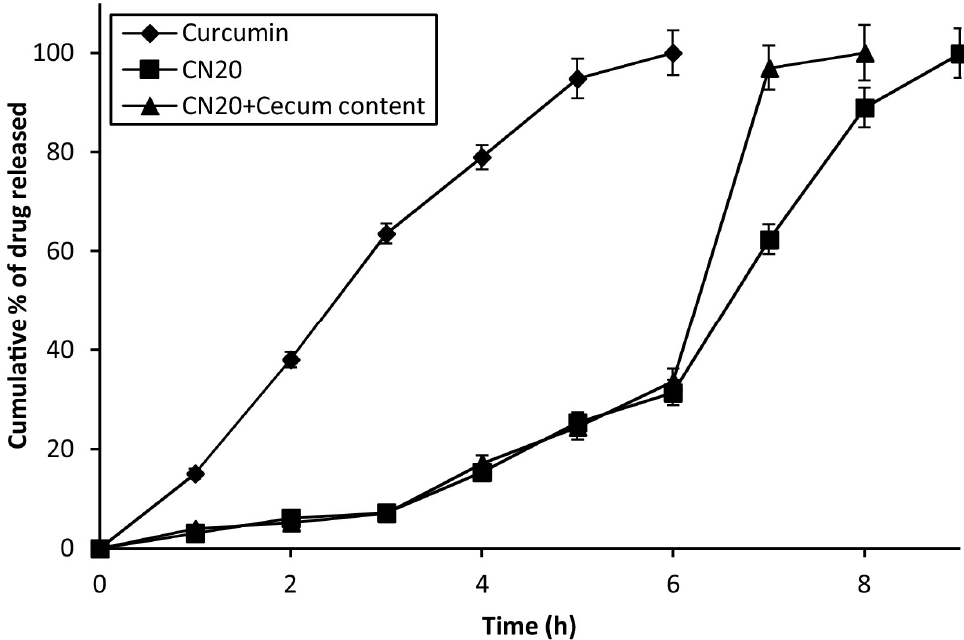
Figure 14. Dissolution profile of pure drug [curcumin] and CN20 NPs [curcumin-loaded poly- acrylamide-grafted-xanthan gum hydrogel]. Reproduced from [134] with